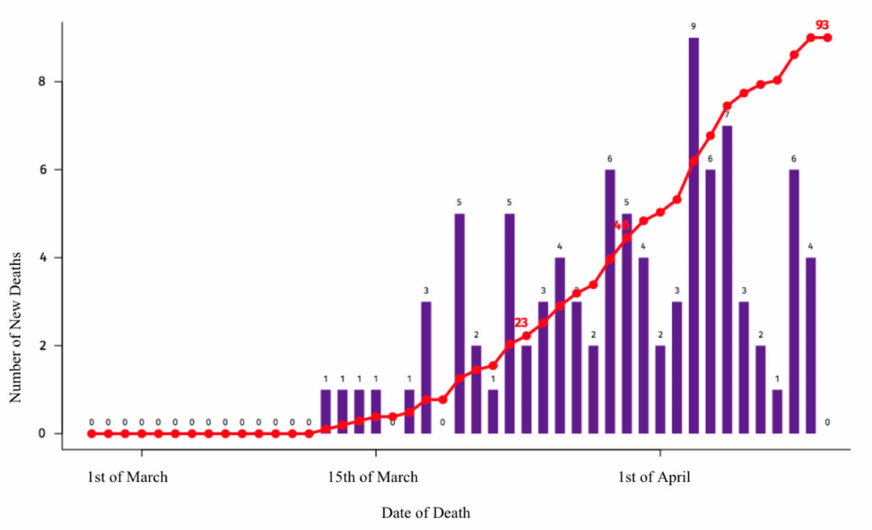
Scheme 3. COVID-19 deaths in Greece as of 11 April 2020 (the red line shows the cumulative number of deaths)